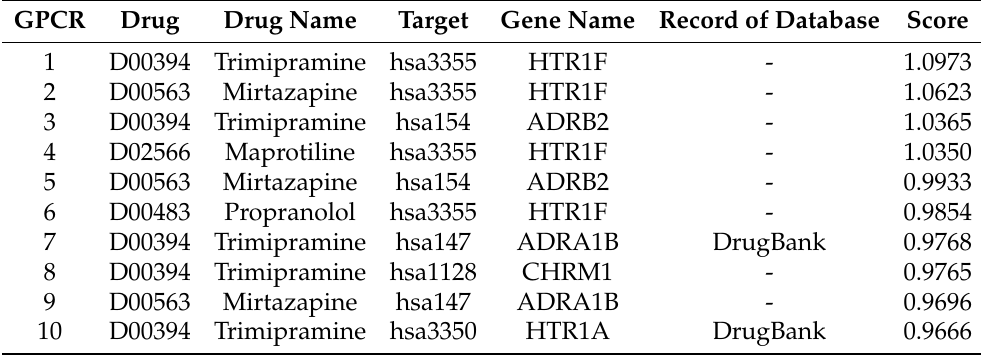
Table A1. Top ten drug–target pairs predicted in